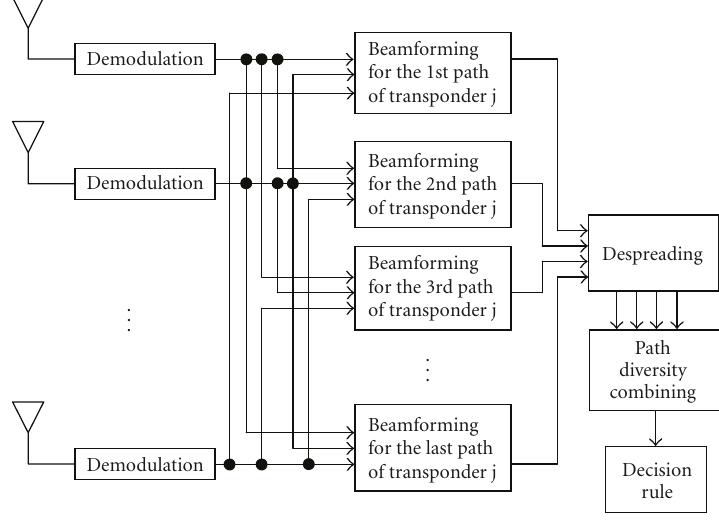
Figure 3: DBS receiver implementation via antenna arrays and DS-CDMA systems.